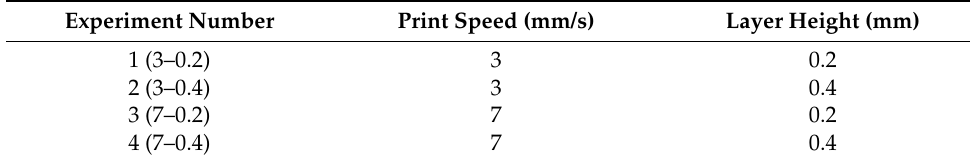
Figure 1. ( a ) Cuboid sample of 9 × 9 × 20 mm 3 ; ( b ) example of a rectilinear infill pattern with a raster angle of 0°; ( c ) extruder; ( d ) example of a printed YSZ part using imaging software (ImageJ); ( e ) sintering cycle. Table 1 defines the speed and layer height values used in the different experiments, according to a 2 2 full factorial design, which was defined with Minitab ® 19.2 version (Minitab Inc., State College, PA, USA). Three replicates of each experiment were performed. Table 1. Print speed and layer height values of the different